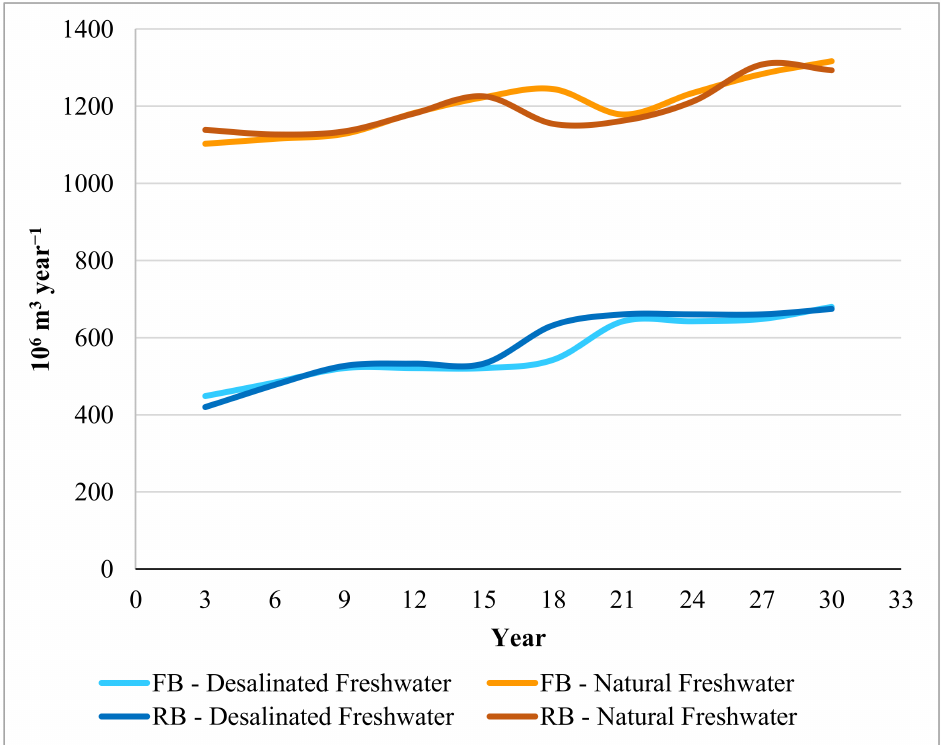
Figure 3. Trajectories of freshwater types supplied from desalination plants and natural sources throughout the simulated 30-year period under the FB and RB scenarios.